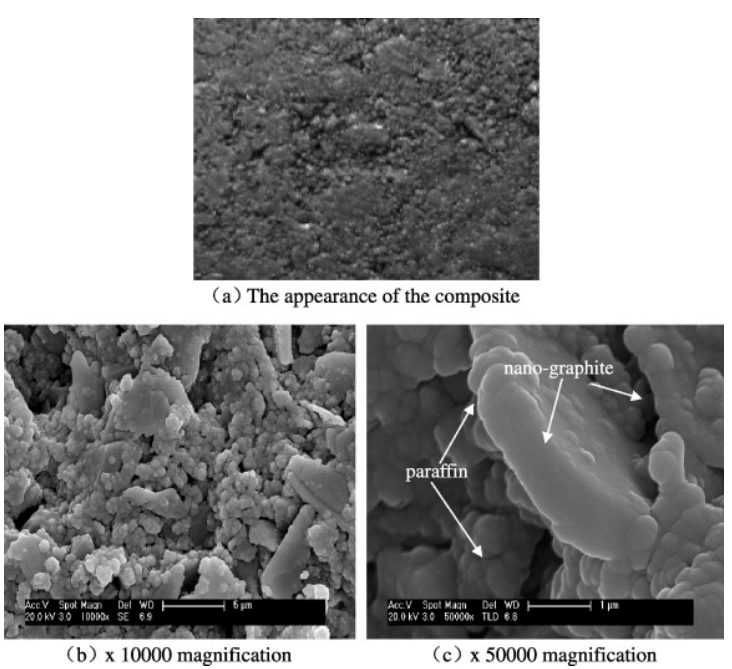
Figure 5. SEM images of paraffin/nano-graphite NEPCM, ( a ) macroscale image of mixture, ( b ) ×10,000 magnified image ( c ) ×50,000 magnified image. (Reprinted with permission from ref. [22]. Copyright 2013 Applied Energy).